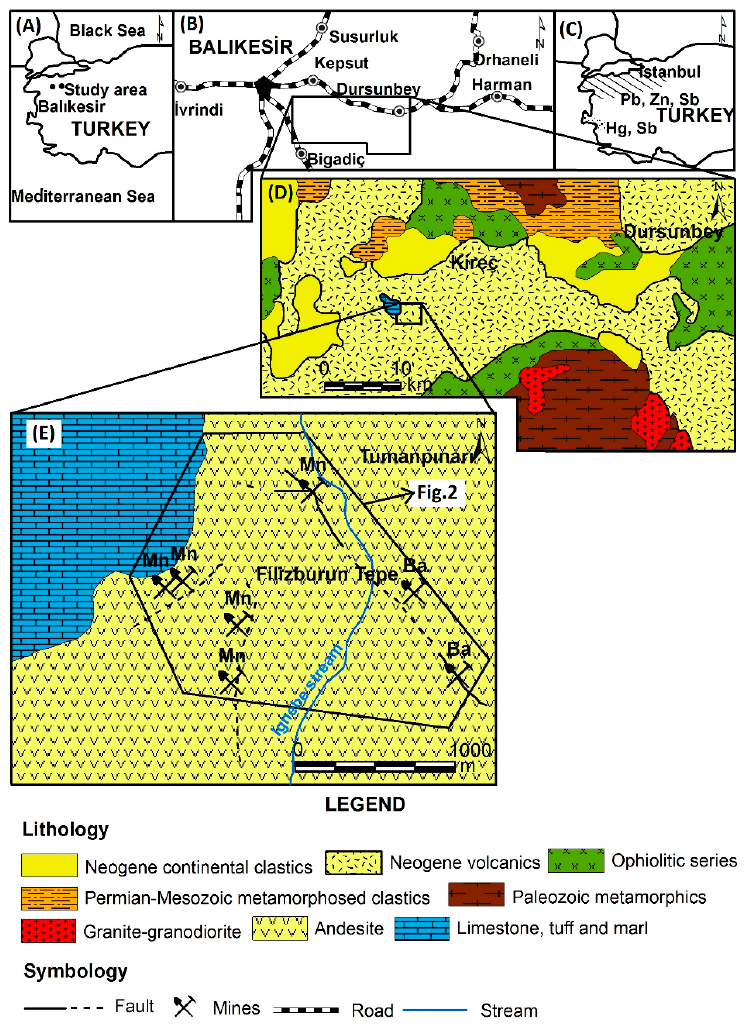
Figure 1. ( A , B ) Location of the study area; ( C ) The Alpine metallogenic units in northwestern Turkey; ( D ) General geological map of the Balıkesir-Dursunbey region [19]; ( E ) Geological map of the Tumanp ı nar ı mineral area.